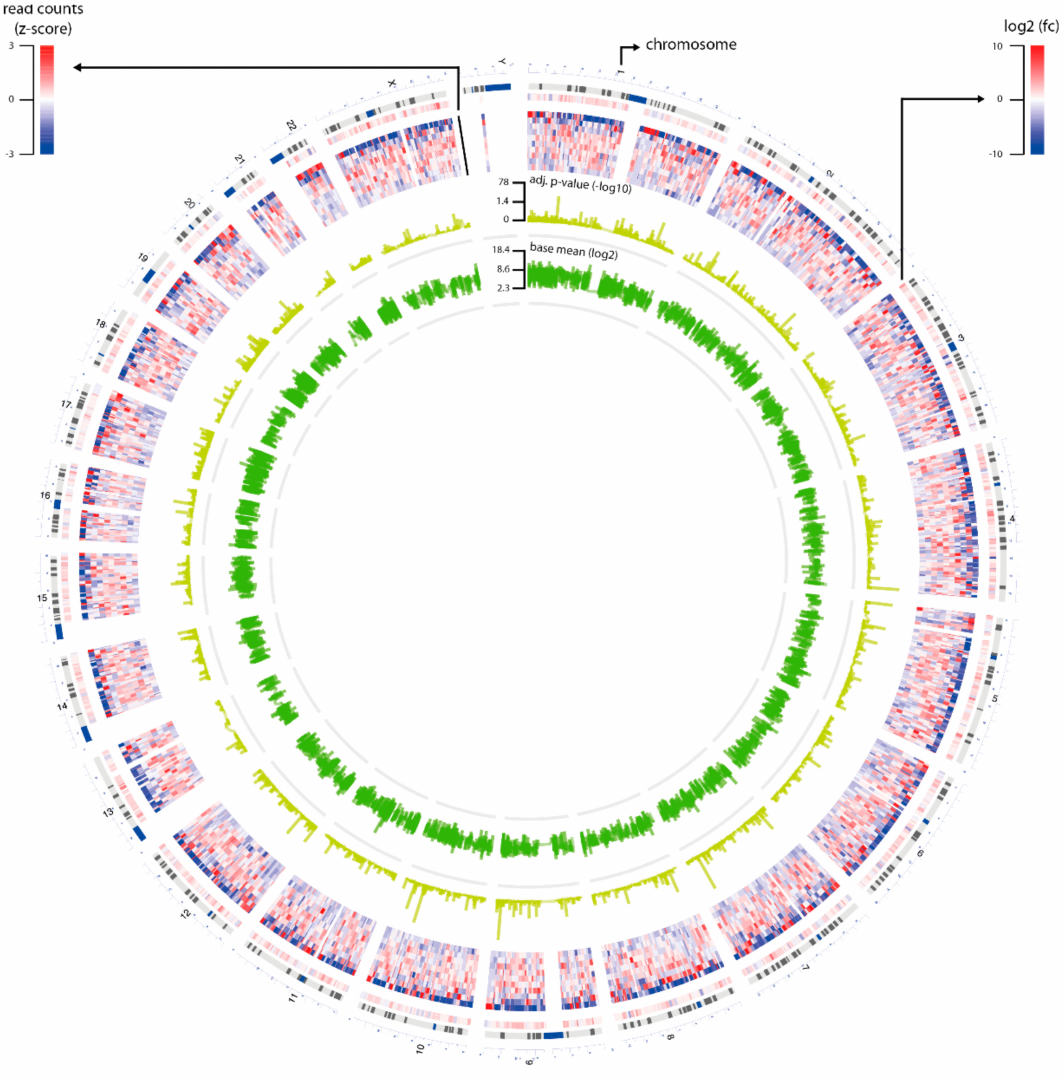
Figure 1. Overview of RNA sequencing data. The circus plot shows statistics of the genes ( n = 16,672) that were selected for di ff erential gene expression analysis. The plot contains four circles: Layer 1 is log2fold-change of the genes; Layer 2 is read counts of the genes that were transformed to z-score; Layer 3 is adjusted p -value of the genes that were transformed by–log10; and Layer 4 is the base mean of the genes that were transformed by